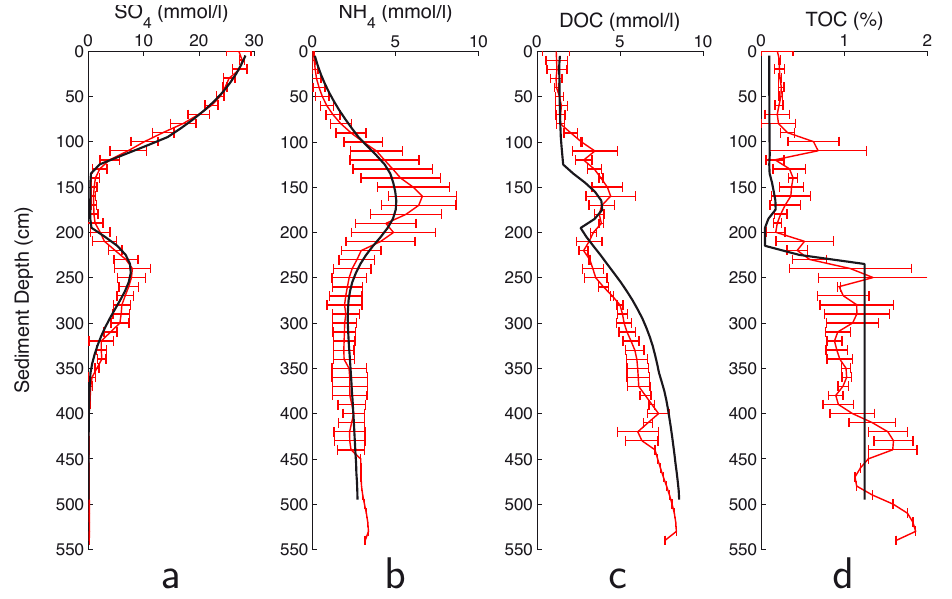
Fig. 6. Scenario A: model results for sulfate, ammonium, DOC and TOC ( black line ) at a sedimentation rate of 2.2cmyr − 1 after 64 years compared to average concentrations of three parallel cores ( red line ). The error bars (red) indicate standard deviation of the parallel cores.